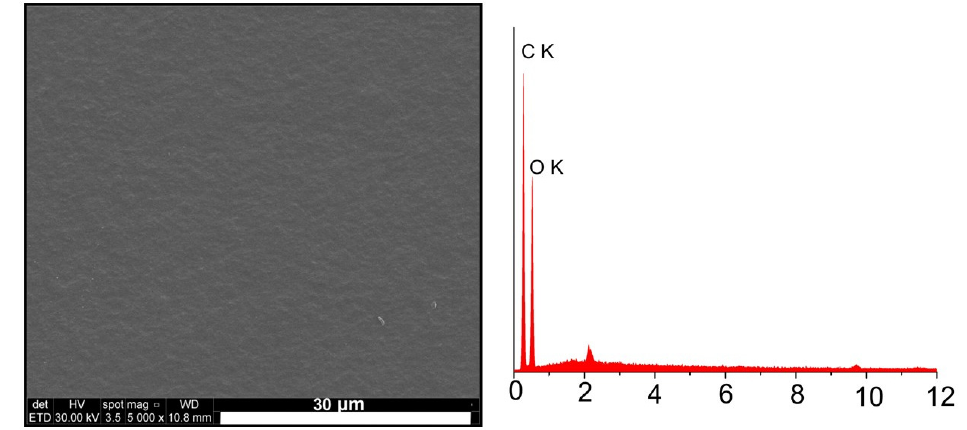
Figure 3. SEM image of the CA sample.